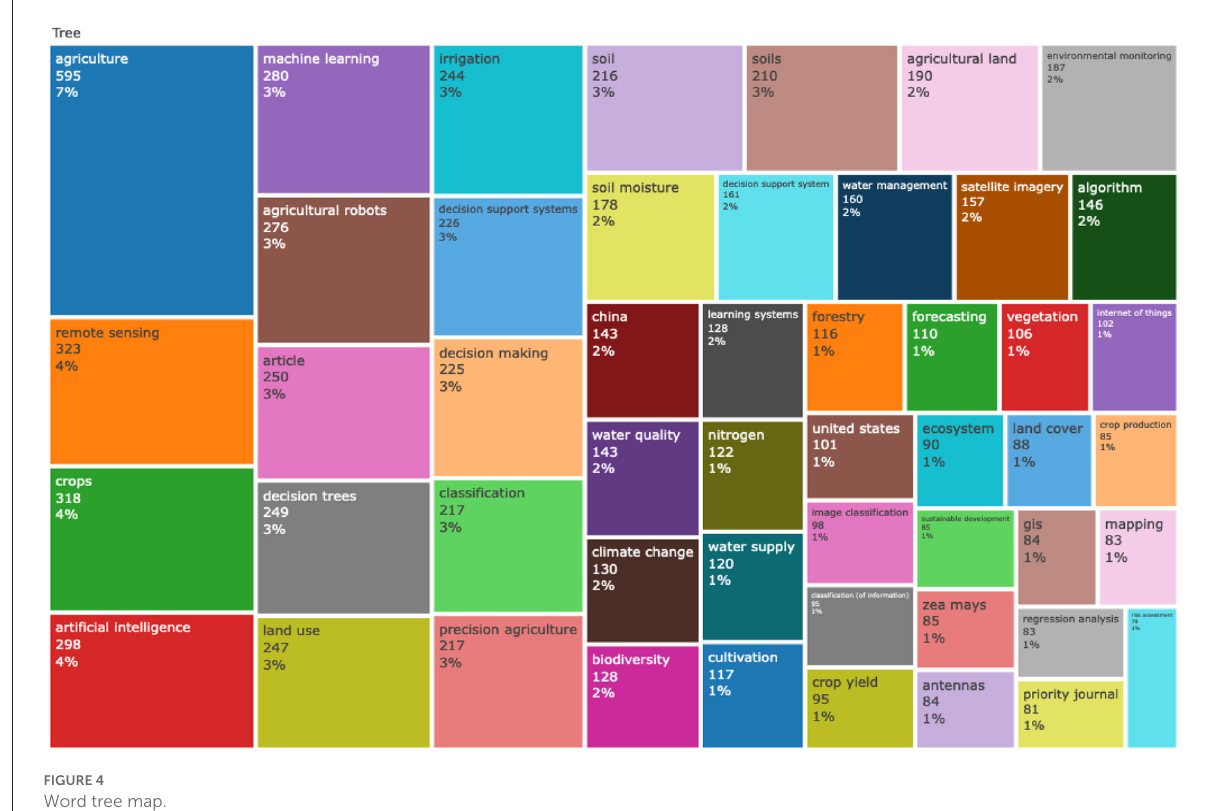
FIGURE4 Word tree